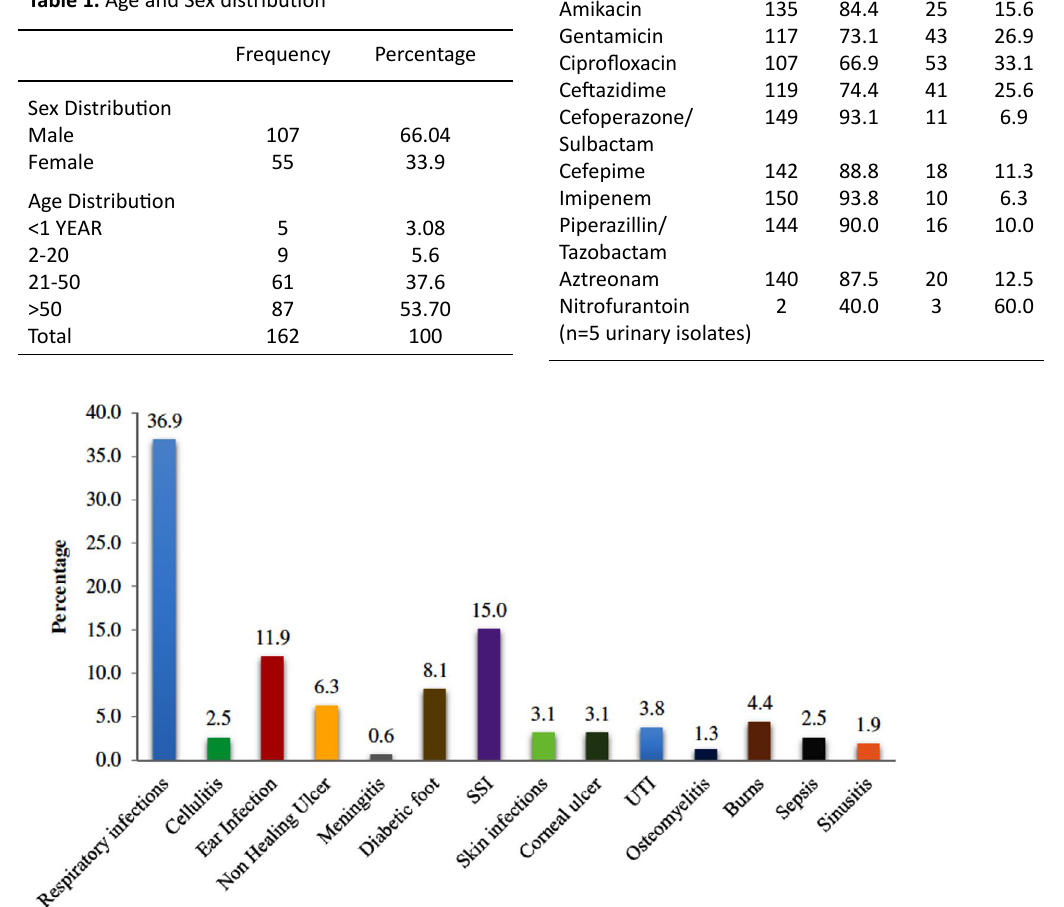
Fig. 2. Distribution of isolates from different clinical